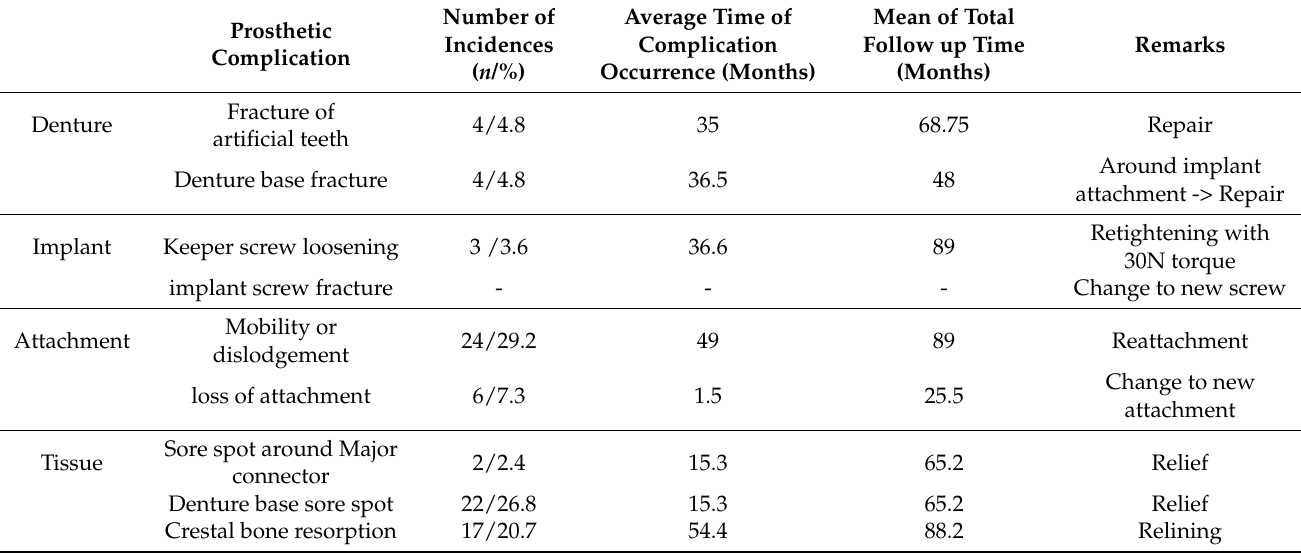
Table 10. Complications in IODs with magnet